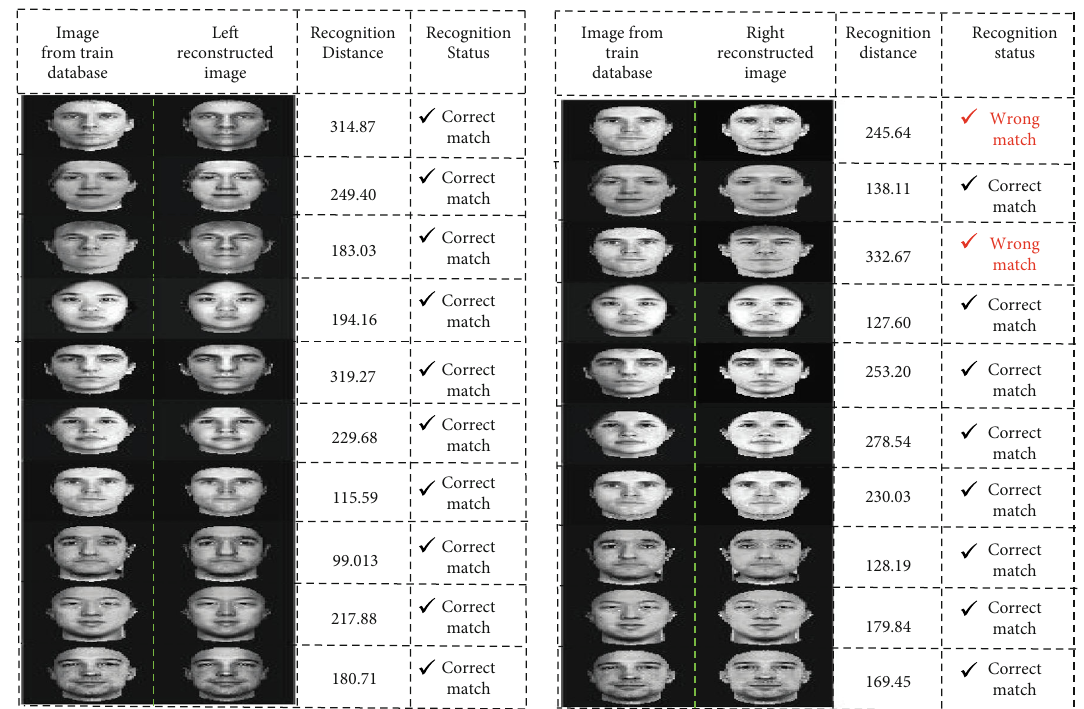
Figure 6: Recognition of the reconstructed images (MIT 2003-2005